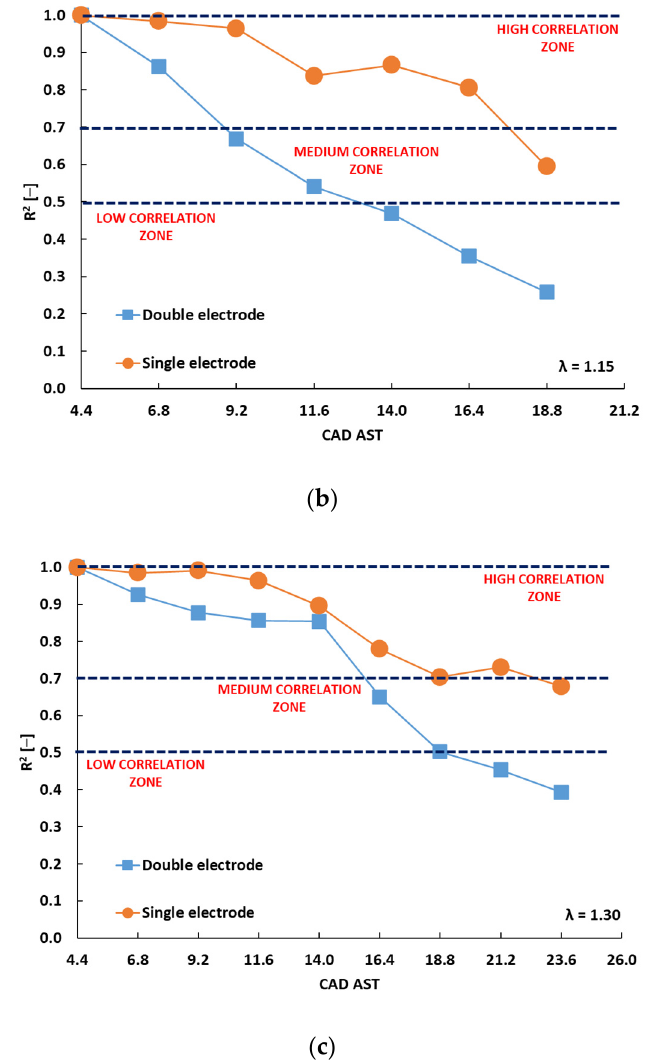
Figure 7. Evolution of the coefficient of determination R 2 of the linear fit between kernel position and flame displacement at CA5 during the early stages of combustion for the cross-flow orientation for the stoichiometric AFR rel value ( a ), for AFR rel 1.15 ( b ), and for AFR rel 1.30 ( c ). For all of the above reported cases, the spark advance was fixed at 12